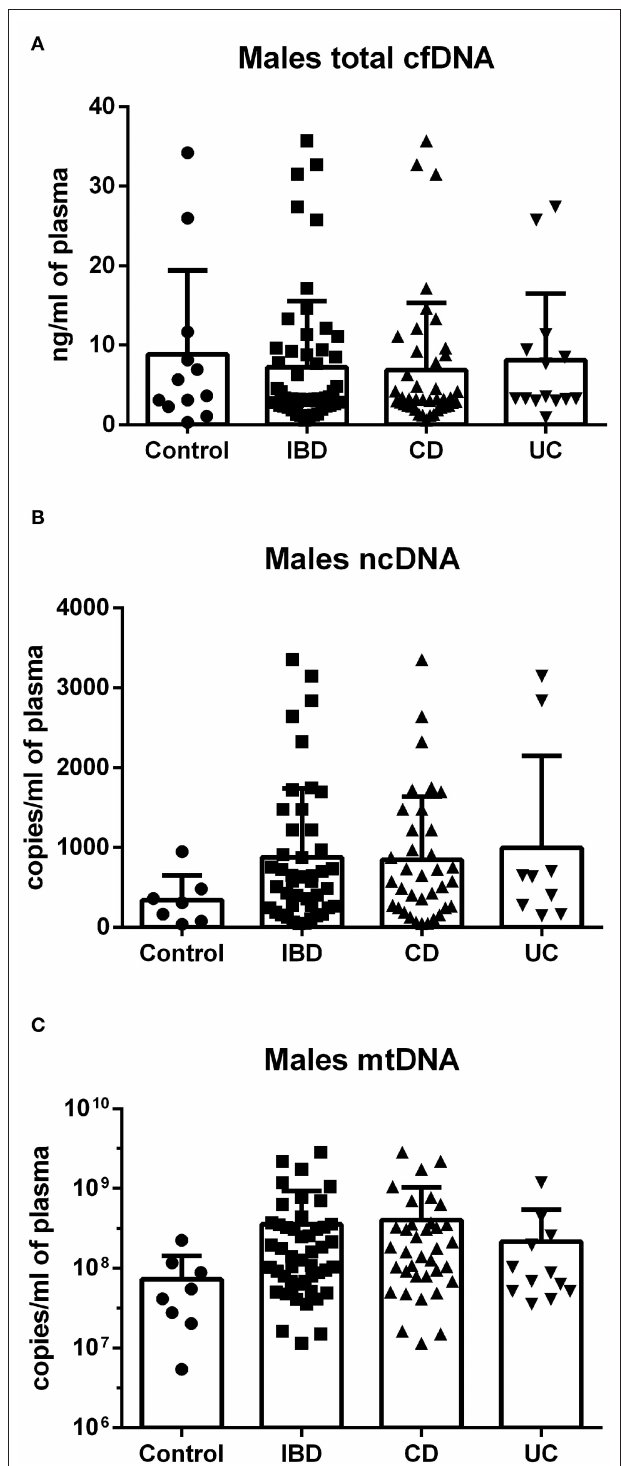
FIGURE 4 | Total cfDNA, ncDNA and mtDNA in males. No significant differences between groups were shown in cfDNA (A) , although a clear trend toward higher ncDNA and mtDNA in IBD patients compared with healthy controls can be seen (B,C) .